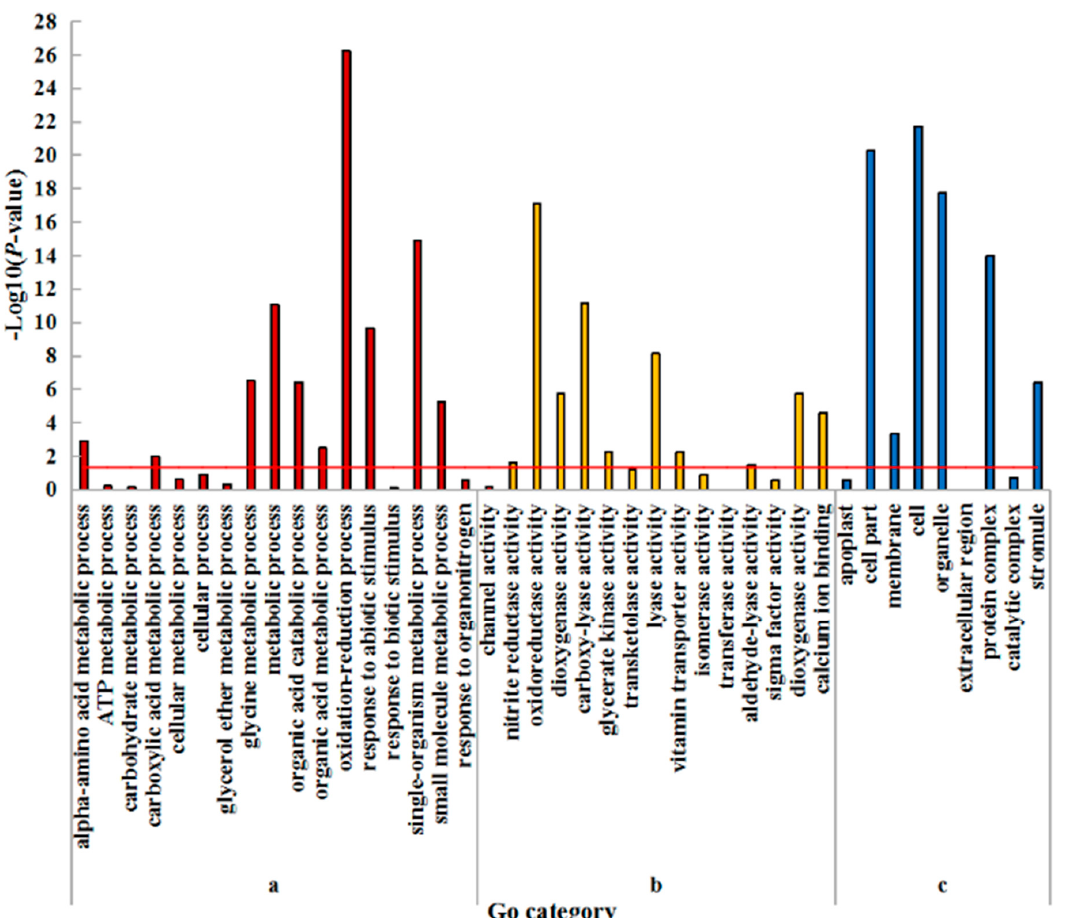
Figure 2. GO enrichment analysis of DEGs in leaves of wheat seedlings. ( a ) Biological process; ( b ) Molecular function; ( c ) Cellular component. The hypergeometric distribution calculates the p -value which determines the significance of enrichment, and the red line represents the p -value of 0.05.